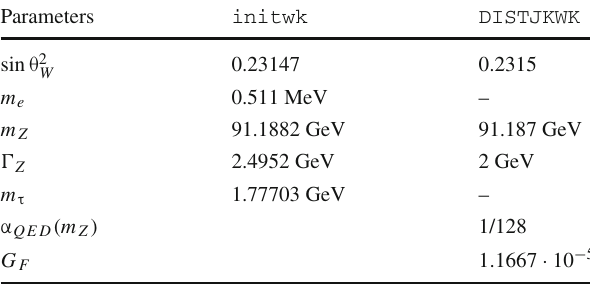
Table 5 Setting of EW parameters in initwk routine for effective Born of Tauola and in routine DISTJKWK of effective Born used in Ref. [12]. Note that the parameters do not match. The purpose of EW parameters in DISTJKWK was to relate New Physics amplitudes with the Standard Model ones, its own calculation scheme of quite rough Standard Model initialization was used